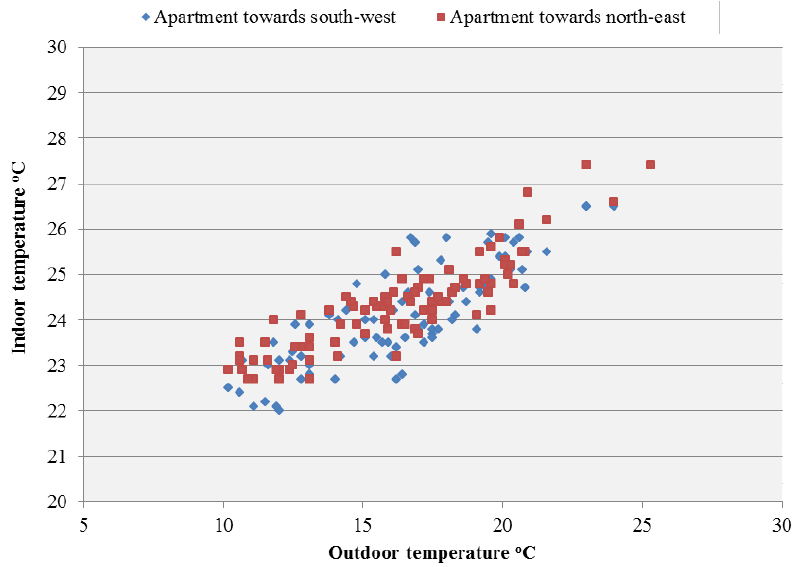
Figure 7. Measured indoor temperatures in two apartments at the last floor in relation to the outdoor